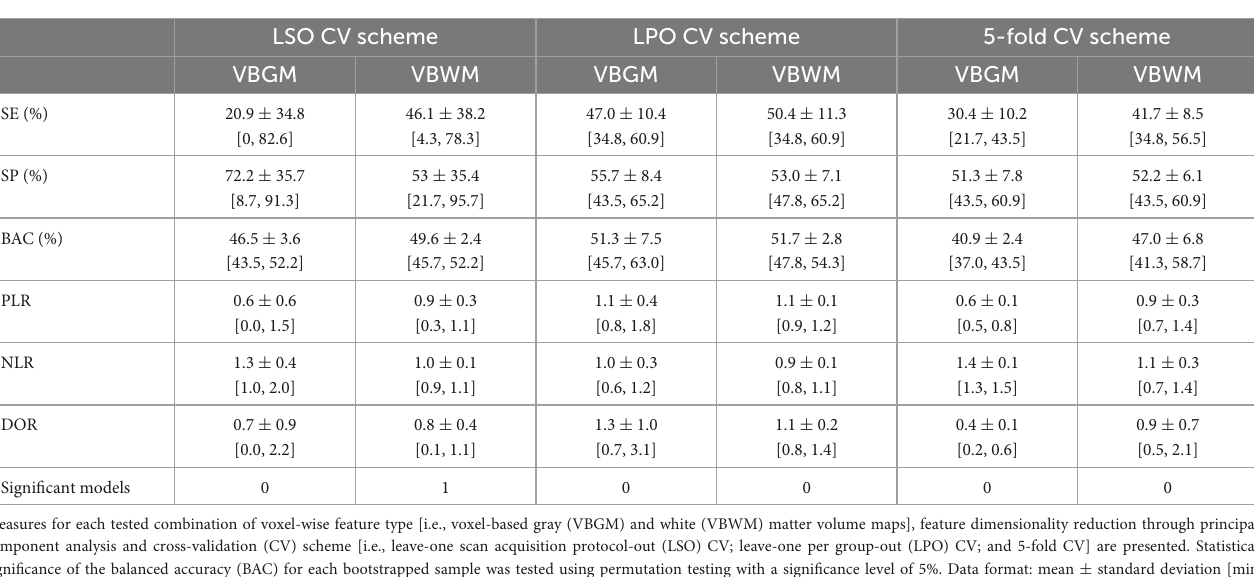
TABLE 5 Performance measures of each structural magnetic resonance imaging (SMRI) classification model based on voxel-wise features across bootstrapped samples.